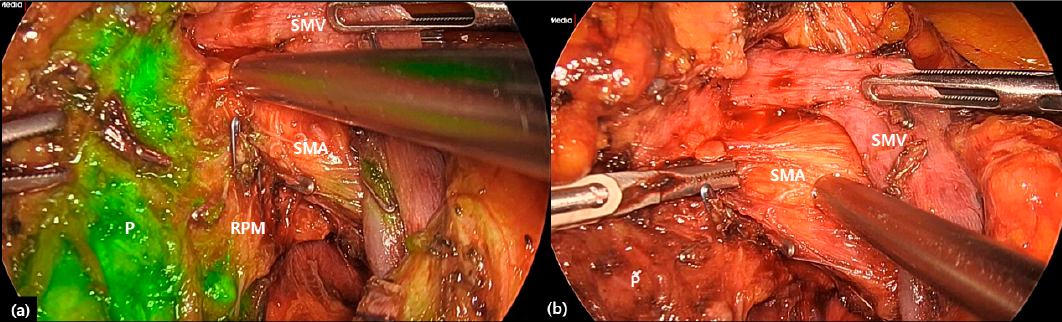
Figure 2. Intraoperative usage of indocyanine green (ICG) during obtaining the retroperitoneal margin of the pancreas. The ICG stained area is part of the uncinated process ( a ), which can be differentiated from the SMA to obtain the retroperitoneal margin ( b ). It can help the surgeon design surgical dissection. Note soft tissue around the SMA (retroperitoneal margin) is not stained by ICG. P; uncinated process of the pancreas, SMA; superior mesenteric artery, SMV; superior mesenteric vein, RPM; retroperitoneal margin.